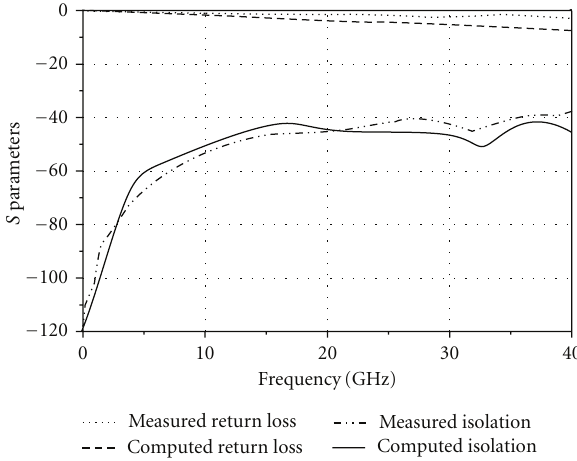
Figure 2: Comparison of the NEMS switch on the “o ff ” state.